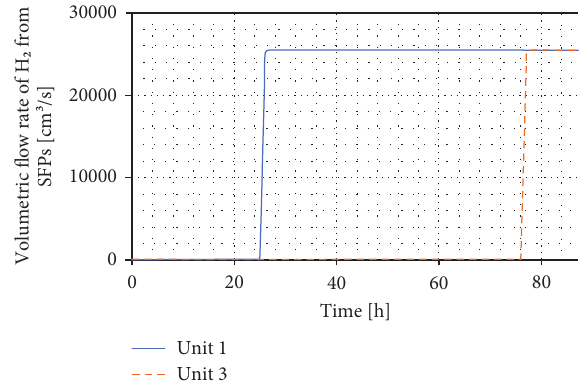
Figure 9: Volumetric flow rates of H calculation in Modified ART Mod